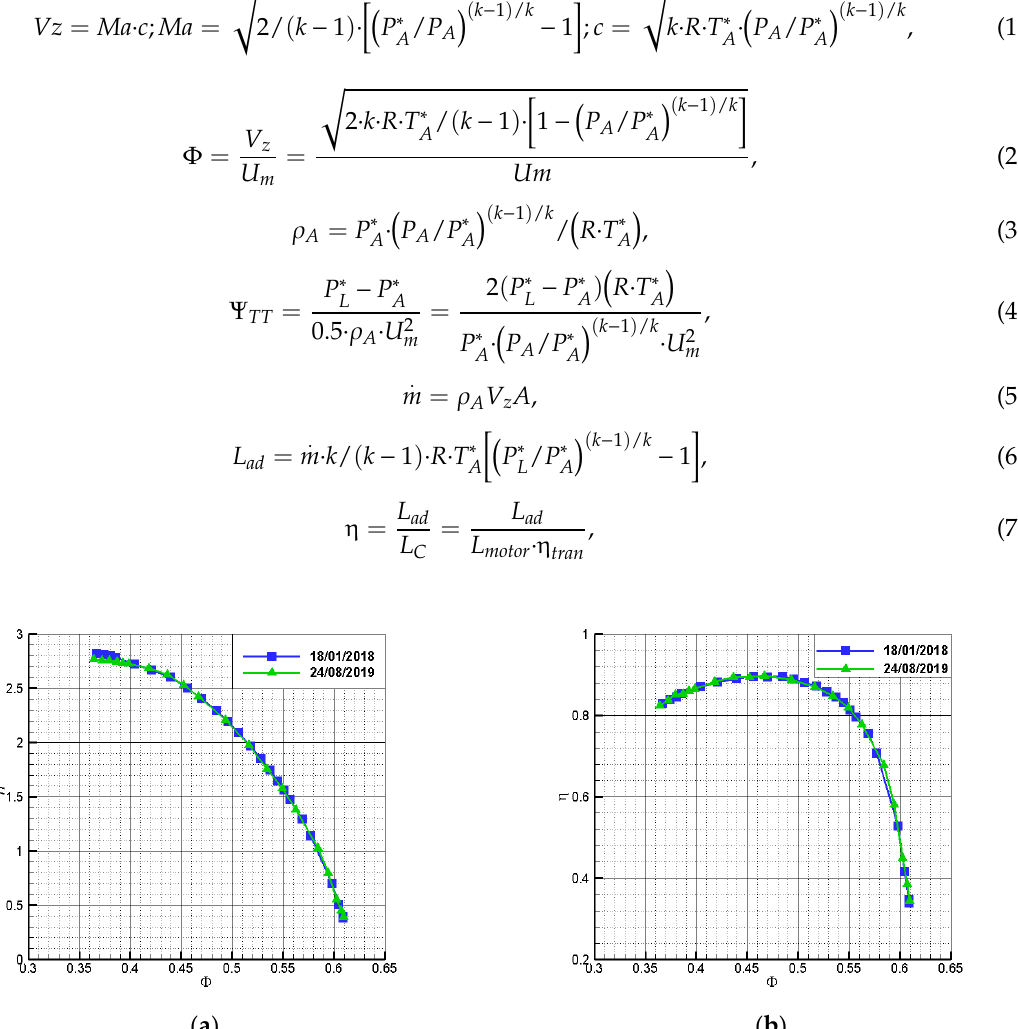
Figure 3. Performance of the LSRC. ( a ) Total pressure rise coefficient versus flow coefficient. ( b ) Total to total isentropic efficiency versus flow coefficient.